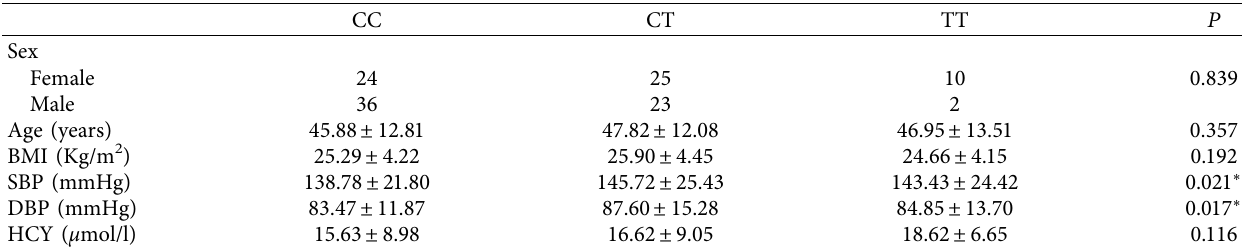
Figure 1: Plots of the expression levels of miR-21, miR-29, and miR-199 in the four groups. The results of multiple comparisons of (a) miR- 21, (b) miR-29, and (c) miR-199 in subjects in CONTROL, HT, hcy, and HT+hcy groups. Data are shown as X ± SD. P values were generated by one-way ANOVA followed by LSD post hoc multiple comparison test. P < 0 . 05 or P < 0 . 001 was considered significant. Table 3: Comparison of baseline characteristics among the four groups of MTHFRC677T genotypes.